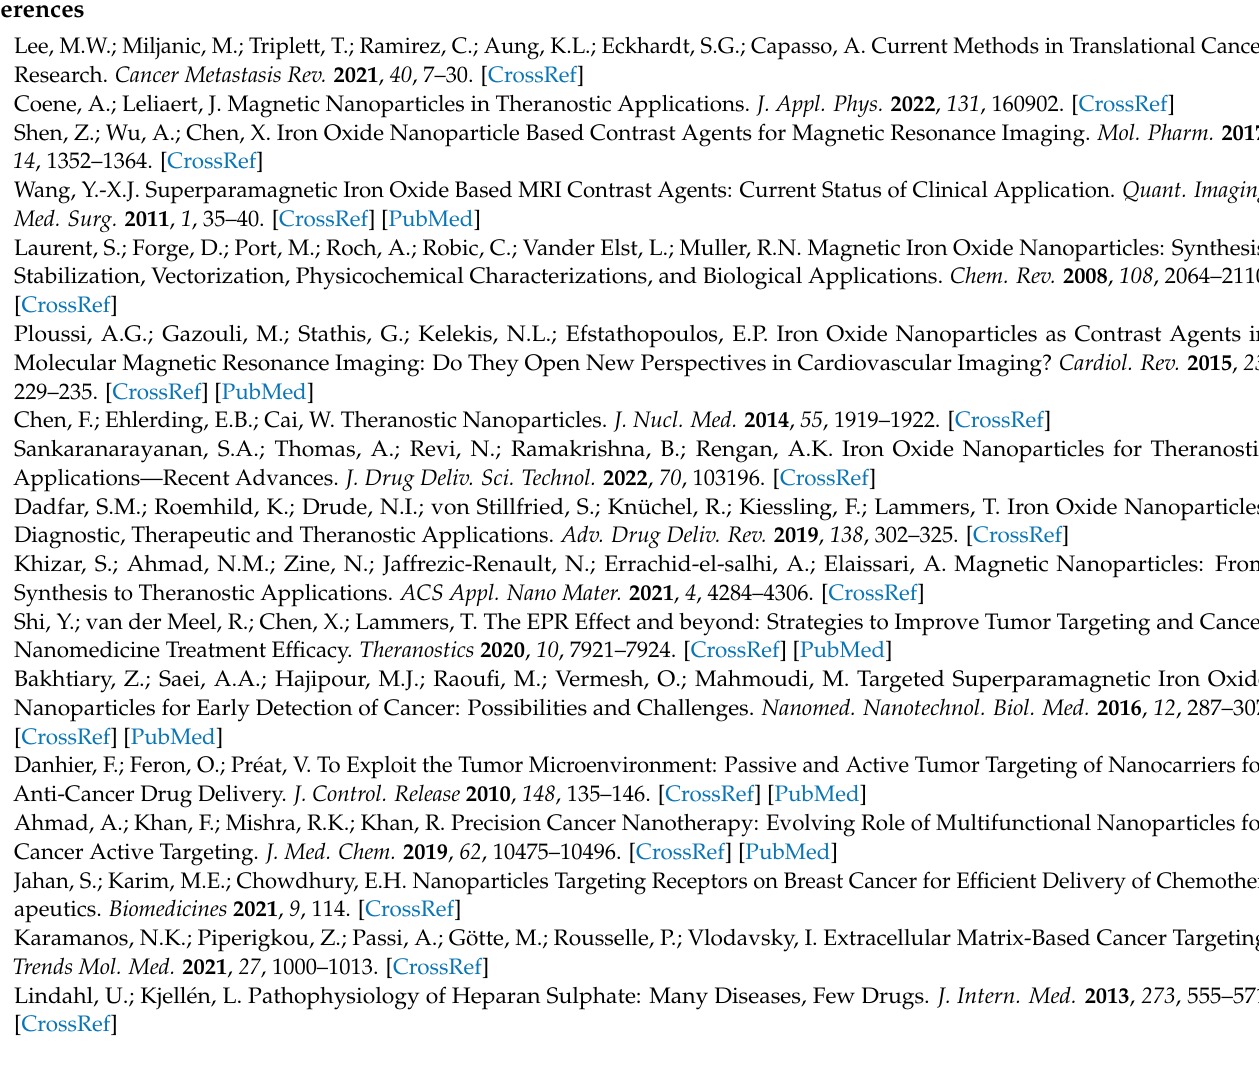
SPION3. Figure S6: FT-IR spectrum of SPION4. Figure S7: PTX release from the SPION3+PTX system. Figure S8: PTX release profile from SPION4+PTX. Refs [63,64] are cited in the Supplementary